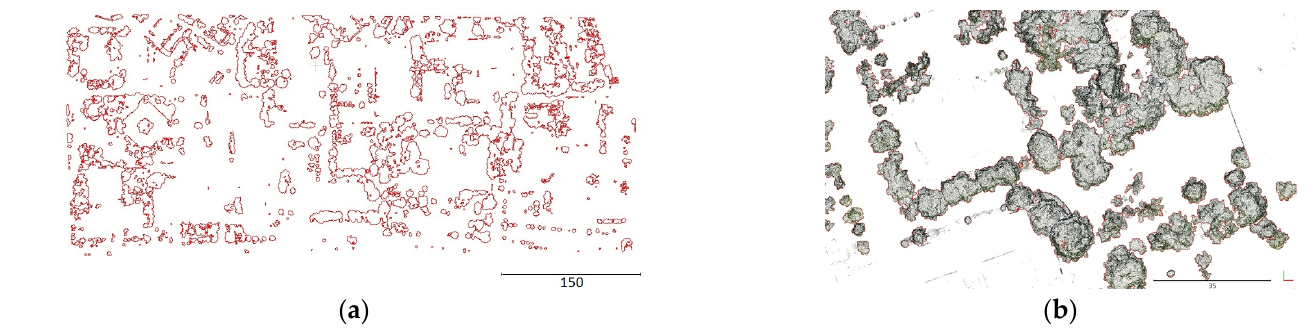
Figure 18. ( a ) The polygons representing vegetation areas with the high greater than 1 m and area greater than 1 m 2 , ( b ) detail with polygons overlaid on the vegetation points.